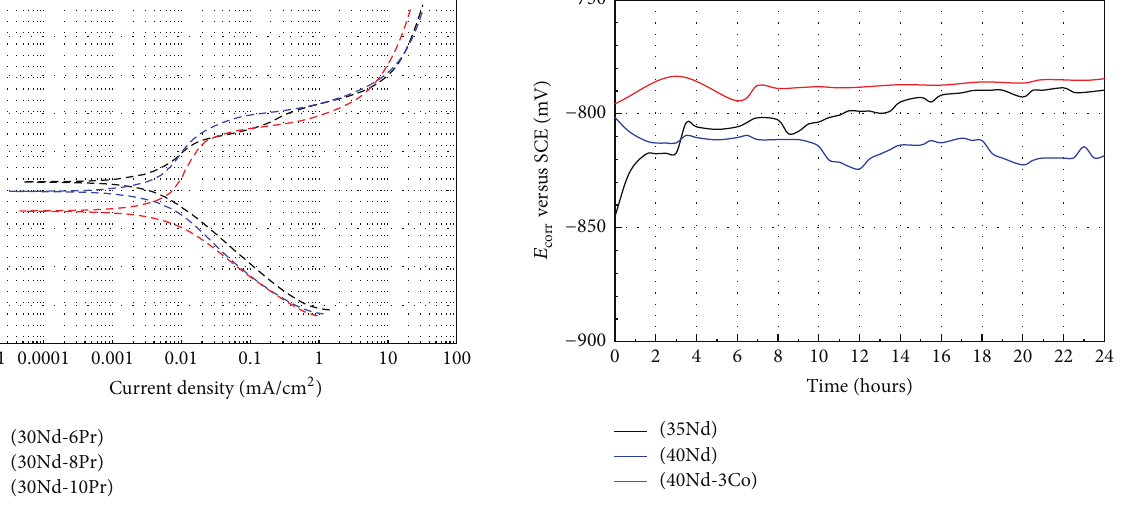
Figure 2: Potentiodynamic polarization curves for NdPr magnets exposed to 3.5% NaCl solutions at 25 ∘ C for 24 hours.